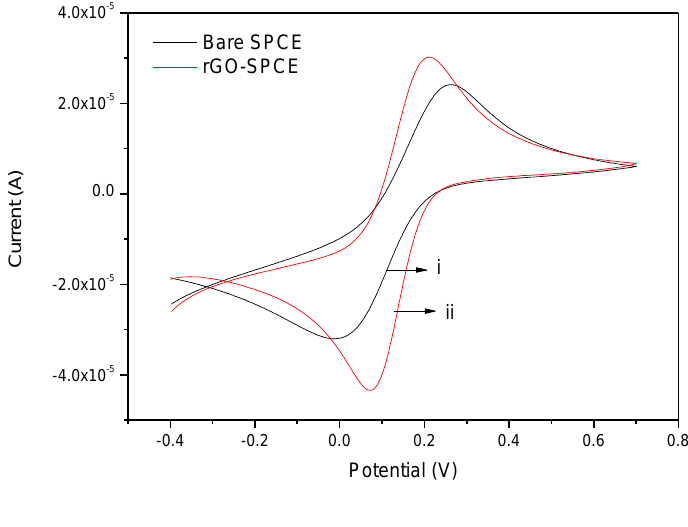
Figure 5. CVs of bare SPCE(i) and rGO-SPCE(ii) in 5 mM K solution. Scan rate: 50